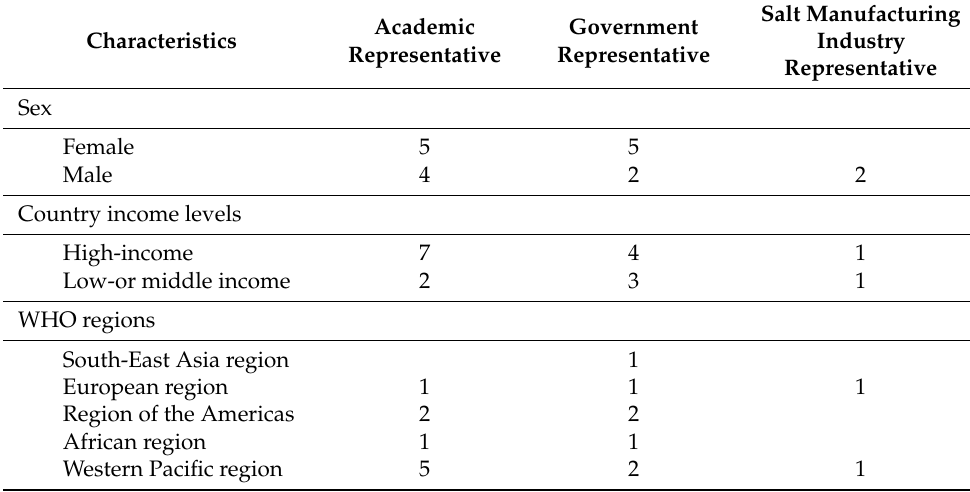
Table 2. Participant